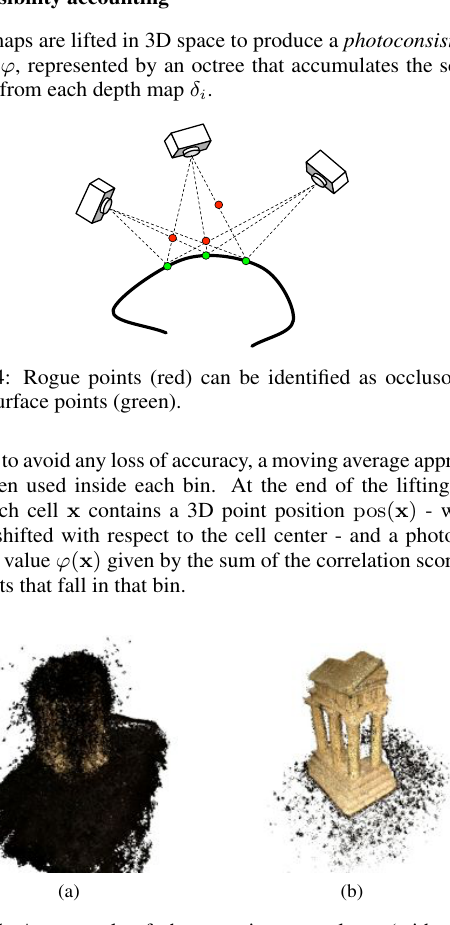
Figure 5: An example of photoconsistency volume (with color) before (a) and after (b) the spurious points removal.